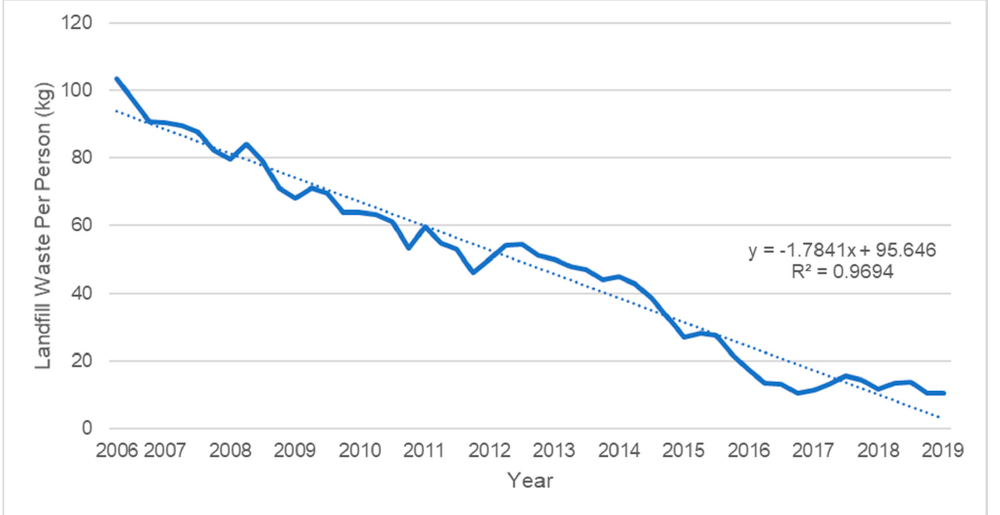
Figure 3. Total landfilled waste per person (kg) per quarter; Welsh average. Source: WasteDataFlow and StatsWales. Dotted line shows trend line represented also in figure by regression equation and coefficient of determination (R 2 ).